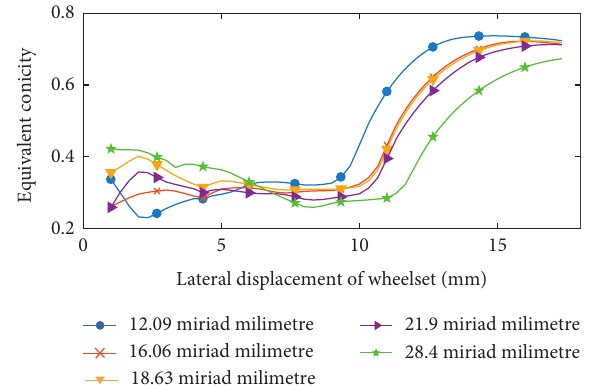
Figure 9: Comparison of the equivalent conicity under different wheel wear conditions with lateral displacement of the wheel set.